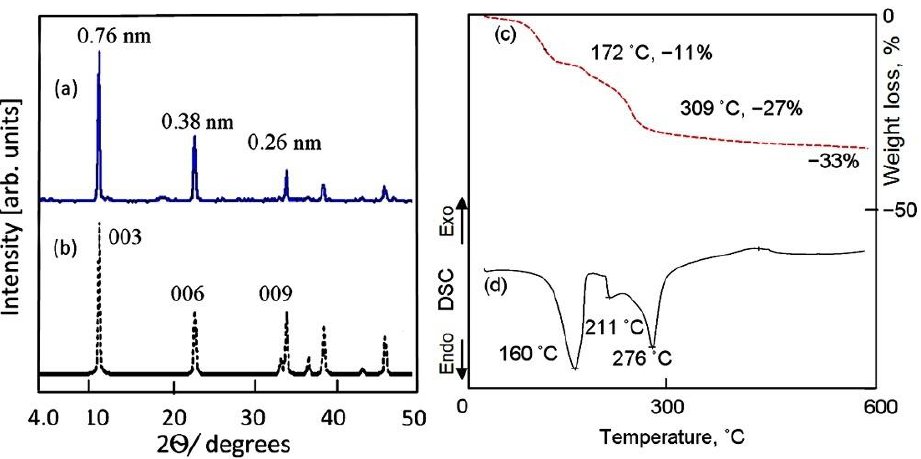
Figure 1. Sample AZ-1: ( a ) X-ray diffraction, ( b ) standard JCPDS file No. 48-1022, ( c ) TG curve and ( d ) DSC curve.